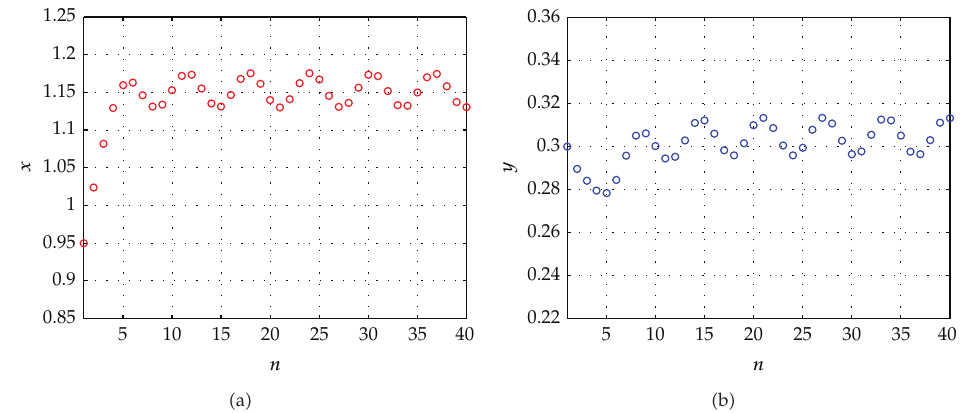
Figure 1: Permanence of (cid:3) 1.9 (cid:4) with { (cid:3) x (cid:3) − 1 (cid:4) ,y (cid:3) − 1 (cid:4)(cid:4) (cid:9) } (cid:5) { (cid:3) 1 . 0 , 0 . 29 (cid:4) (cid:9) } and { (cid:3) x (cid:3) 0 (cid:4) ,y (cid:3) 0 (cid:4)(cid:4) (cid:9) } (cid:5) { (cid:3) 0 . 95 , 0 . 3 (cid:4) (cid:9) } . (cid:3) a (cid:4) Time series of x for n ∈ (cid:8) 0 , 40 (cid:9) . (cid:3) b (cid:4) Time series of y for n ∈ (cid:8) 0 , 40 (cid:9)